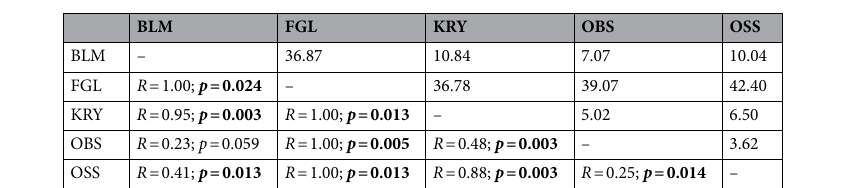
Table 2. Results of pairwise multilevel comparison of segregation among the five colonies (BLM = Blomstrand; FGL = Fuglehuken; KRY = Krykkjefjellet; OBS = Observasjonsholmen; OSS = Ossian Sarsfjellet) in Kongsfjorden using ANOSIM ( R ; below diagonal) and the distance (km) separating each pair of colonies (upper diagonal). Significance (shown in bold) was evaluated along 999 permutations using the false-discovery rate correction for multiple testing (see “Methods”